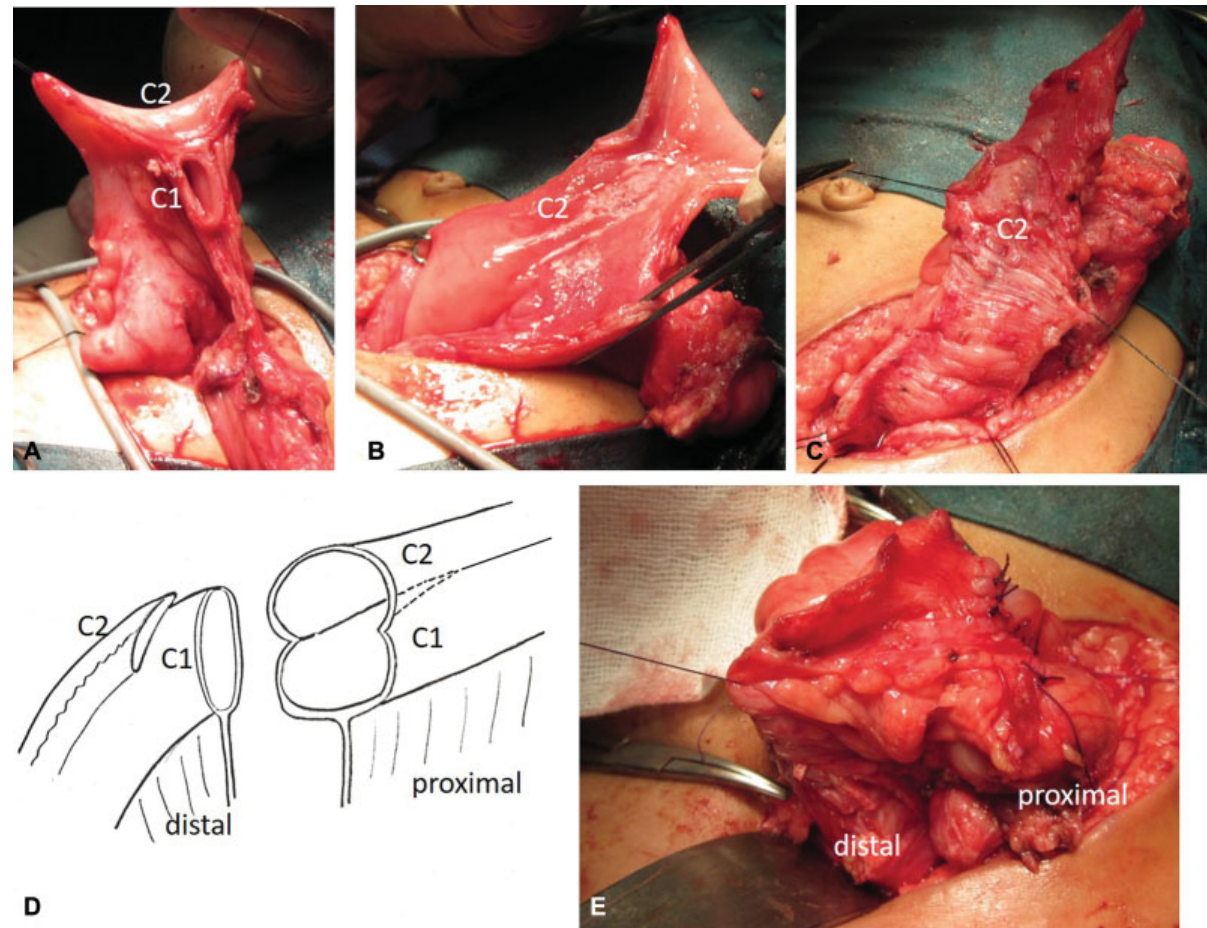
Fig. 2 Intraoperative photos and diagram representing extra-mucosal excision of the antimesenteric distal colon (C2) and rectum. ( A ) The distal colon to be excised (C2) was incised along its free antimesenteric border; ( B ) submucosal injection of adrenaline/saline solution (1/200,000) to control bleeding and elevate the mucosa (hydrodissection); ( C ) stripping of the mucosa off this distal colon and rectum; ( D, E ) the continuity of the fecal stream was then restored by anastomosing the proximal double colonic lumens with the retained distal colon (C1) in a Y-shape fashion. Note the limited terminal septotmy for the common wall between the proximal double colonic lumens in ( D